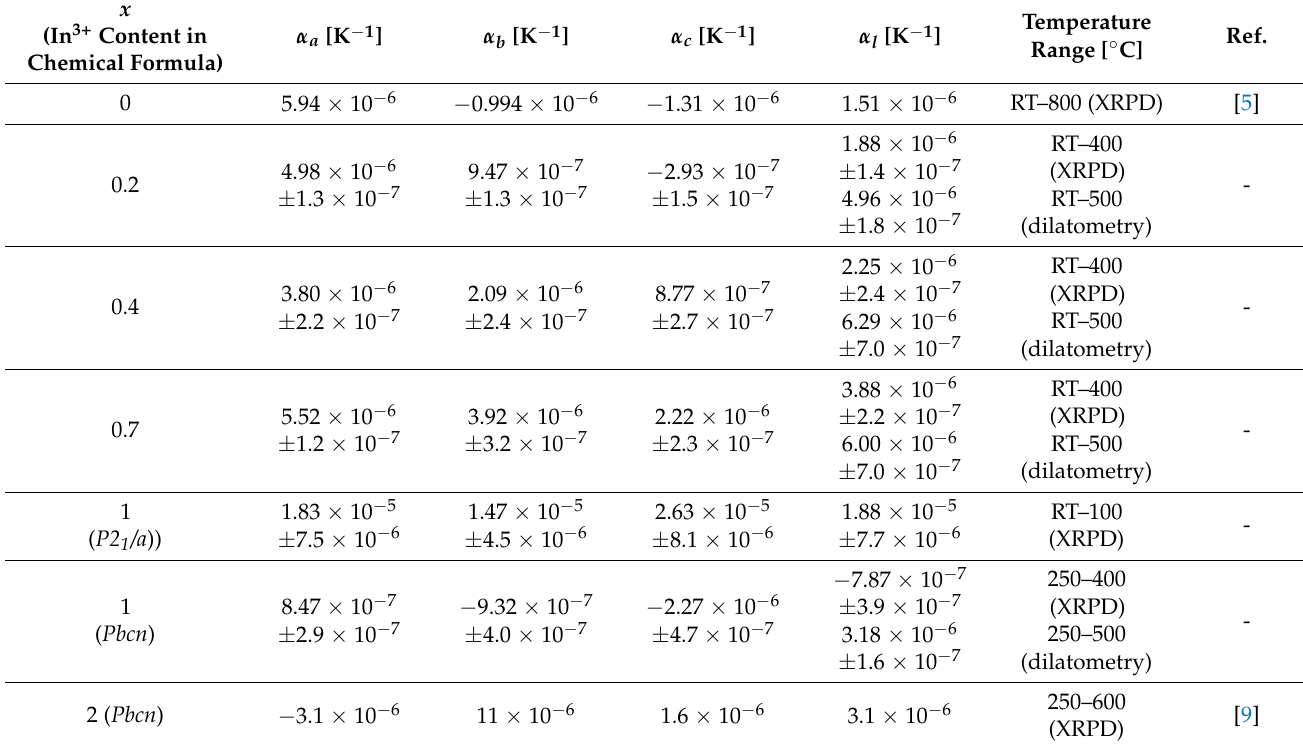
Table 1. Intrinsic and extrinsic CTEs by axis ( α a , α b , α c ) and average linear CTE ( α l ) in the Al 2 − x In x W 3 O 12 system ( Pbcn space group for the orthorhombic phase and P2 1 /a for the monoclinic phase) with their standard deviations (standard deviations for x = 1 in monoclinic form are one order of magnitude higher than for others, since only three points were considered). Standard deviations for CTEs of the end-members are not reported in the literature [5,9]. Results not referenced to the literature are from the present study. RT refers to room